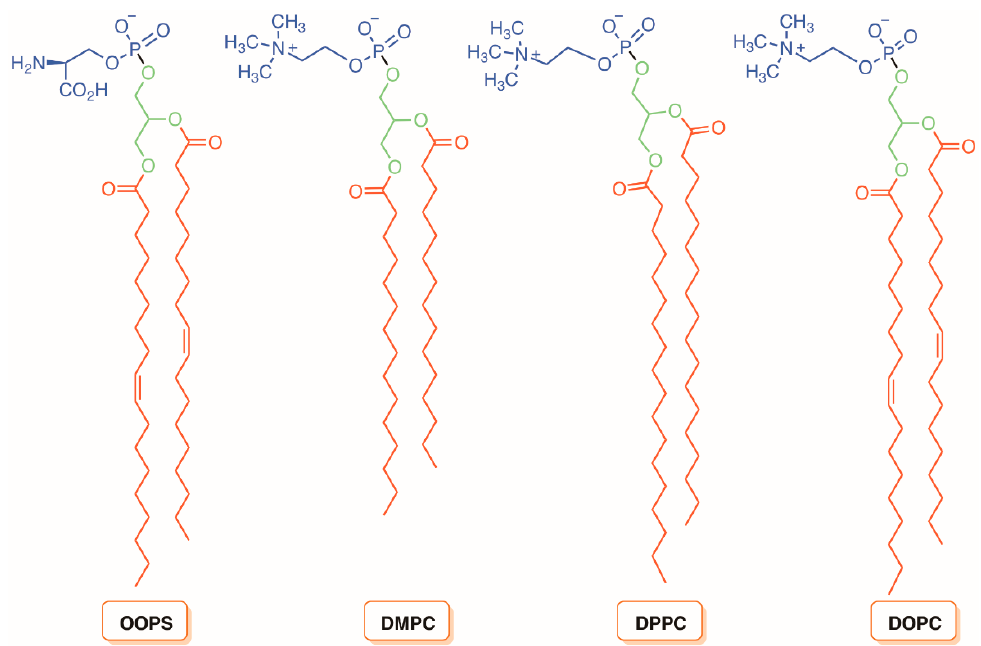
Figure 31. Structure of phospholipids L - α -dioleoylphosphatidylserine (OOPS), L - α - dimiristoylphosphatidylcholine (DMPC), L - α -dipalmitoylphosphatidylcholine (DPPC), and 1,2-dioleoyl- sn -glycerophosphatidylcholine (DOPC) (adapted from Reference [69]).